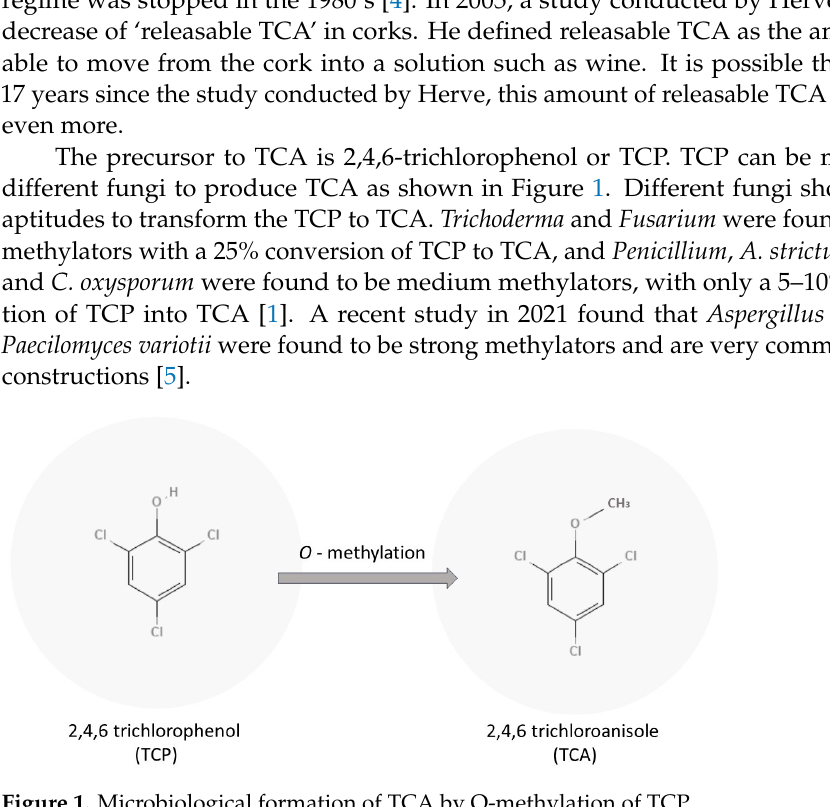
Figure 1. Microbiological formation of TCA by O-methylation of TCP.